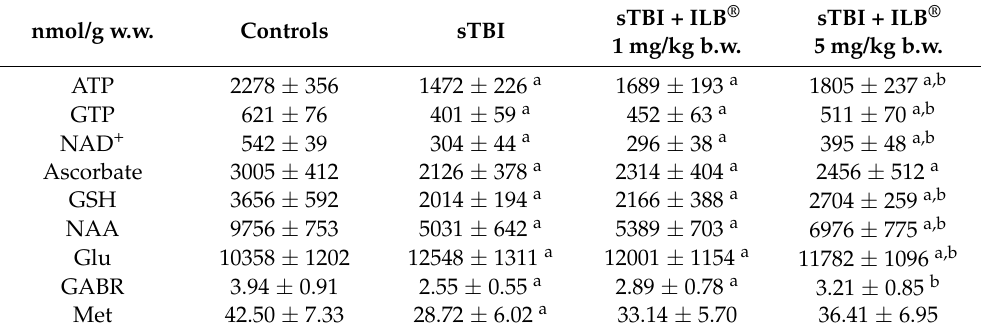
Table 1. Concentrations of selected cerebral metabolites determined in deproteinized brain extracts of rats undergoing the neurocognitive study. Control rats received surgical procedures and not sTBI, whilst the other three groups experienced sTBI. Those treated with ILB ® received a subcutaneous injection of the drug (at the two dose levels indicated in the table), 30 min after sTBI induction. Animals were sacrificed 7 days post-sTBI or surgical procedure (in the case of sham operated controls). sTBI + ILB ® sTBI + ILB ® nmol/g w.w. Controls sTBI 1 mg/kg b.w. 5 mg/kg b.w. ATP 2278 ± 356 1472 ± 226 a 1689 ± 193 a 1805 ± 237 a,b GTP 621 ± 76 401 ± 59 a 452 ± 63 a 511 ± 70 a,b NAD + 542 ± 39 304 ± 44 a 296 ± 38 a 395 ± 48 a,b Ascorbate 3005 ± 412 2126 ± 378 a 2314 ± 404 a 2456 ± 512 a GSH 3656 ± 592 2014 ± 194 a 2166 ± 388 a 2704 ± 259 a,b NAA 9756 ± 753 5031 ± 642 a 5389 ± 703 a 6976 ± 775 a,b Glu 10358 ± 1202 12548 ± 1311 a 12001 ± 1154 a 11782 ± 1096 a,b GABR 3.94 ± 0.91 2.55 ± 0.55 a 2.89 ± 0.78 a 3.21 ± 0.85 b Met 42.50 ± 7.33 28.72 ± 6.02 a 33.14 ± 5.70 36.41 ± 6.95 Values are the mean ± S.D. of 12 different animals. GABR = global arginine bioavailability ratio = Arg/Orn + Citr.